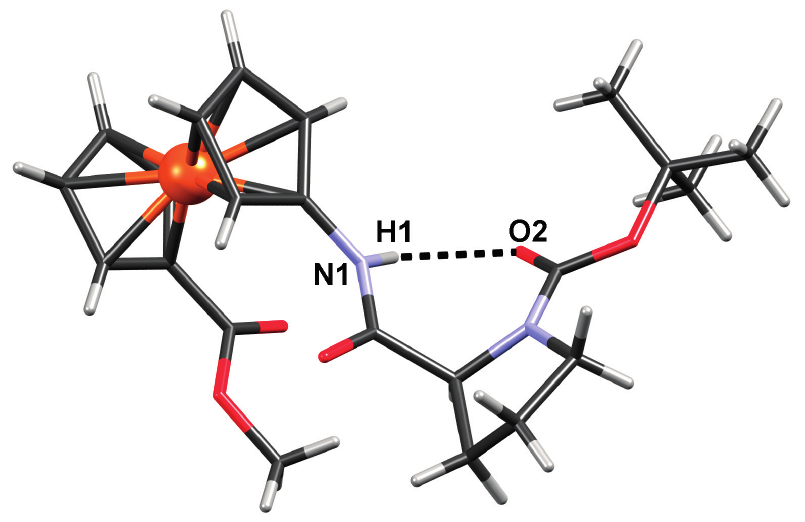
Figure 8. Conformation of Boc-Pro-Fca-OMe ( 3 ) in the crystal stabilised by intrachain intramolecular hydrogen